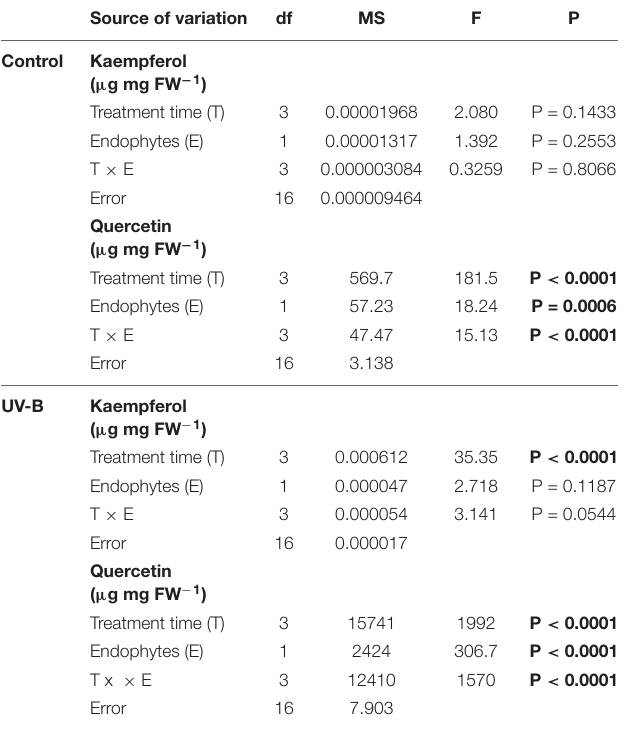
TABLE 4 | Results of factorial ANOVAs evaluating the interactive effects of endophytes presence (E) and different treatment times for (control: without radiation UV-B radiation, UV-B: 46 µ mol m − 2 s − 1 ) for flavonol content ( µ g